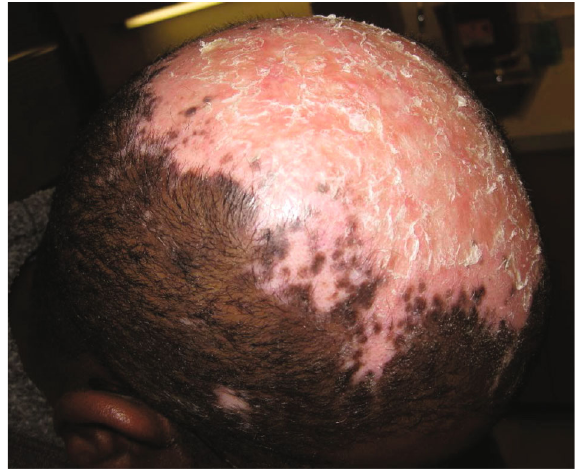
Figure 6: Scarring alopecia as a result of discoid lupus on the scalp of this male